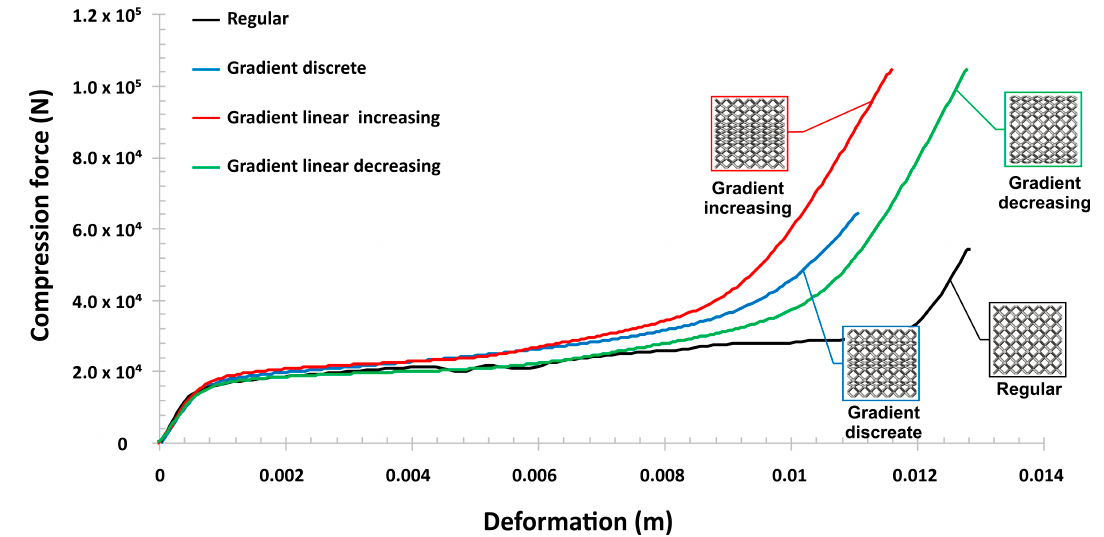
Figure 10. Deformation force versus displacement history plots registered for various lattice structure specimens.